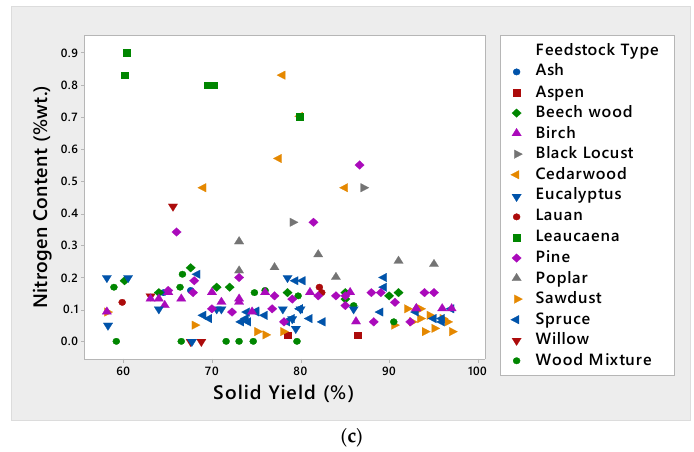
Figure 1. Variation of ( a ) Carbon (% wt.) ( b ) Hydrogen (% wt.) and ( c ) Nitrogen (% wt.) with solid yield for different types of torrefied wood.